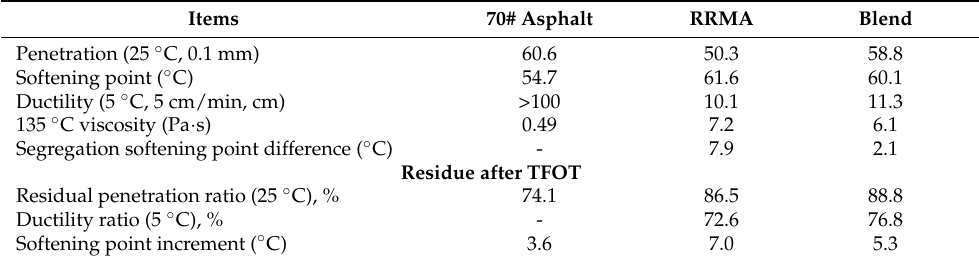
Table 3. Conventional properties of 70# asphalt, RRMA and Blend.